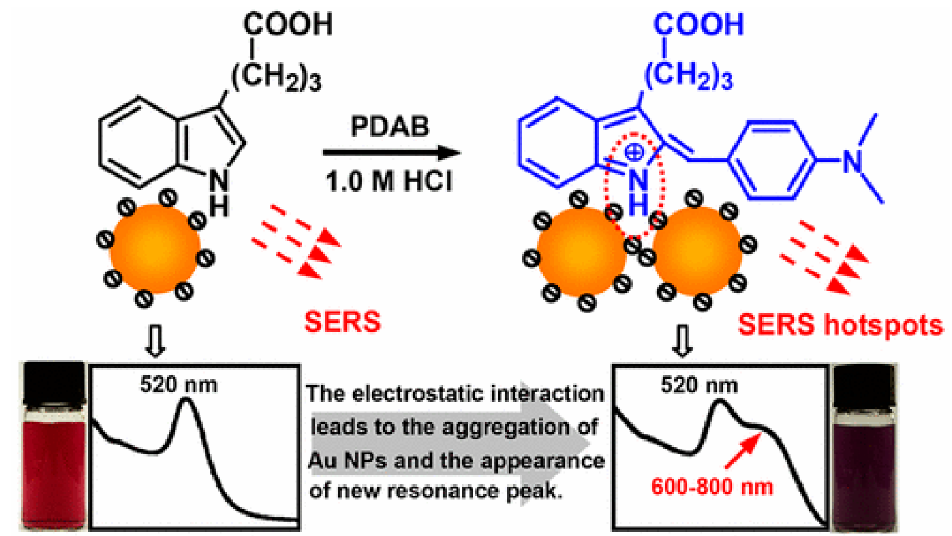
Figure 3. Combination Ehrlich reaction with AuNPs for ultrasensitive detection of indole-3-butyric acid. Reproduced from ref. [185], with permission from American Chemical Society, 2017.